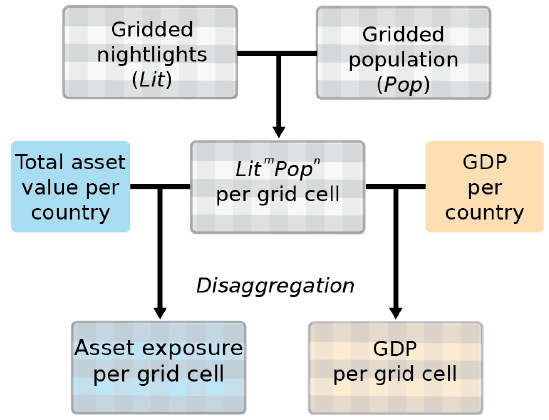
Figure 1. Work flow of the LitPop downscaling: gridded night- lights (Lit) and population (Pop) data are combined to compute gridded digital number Lit m Pop n (Eq. 1). Then, total asset value per country (i.e., produced capital or nonfinancial wealth) is disag- gregated proportionally to Lit m Pop n to obtain gridded asset expo- sure data (Eq. 2). GDP is disaggregated in the same way and com- pared against reported GRP for the evaluation of the downscaling